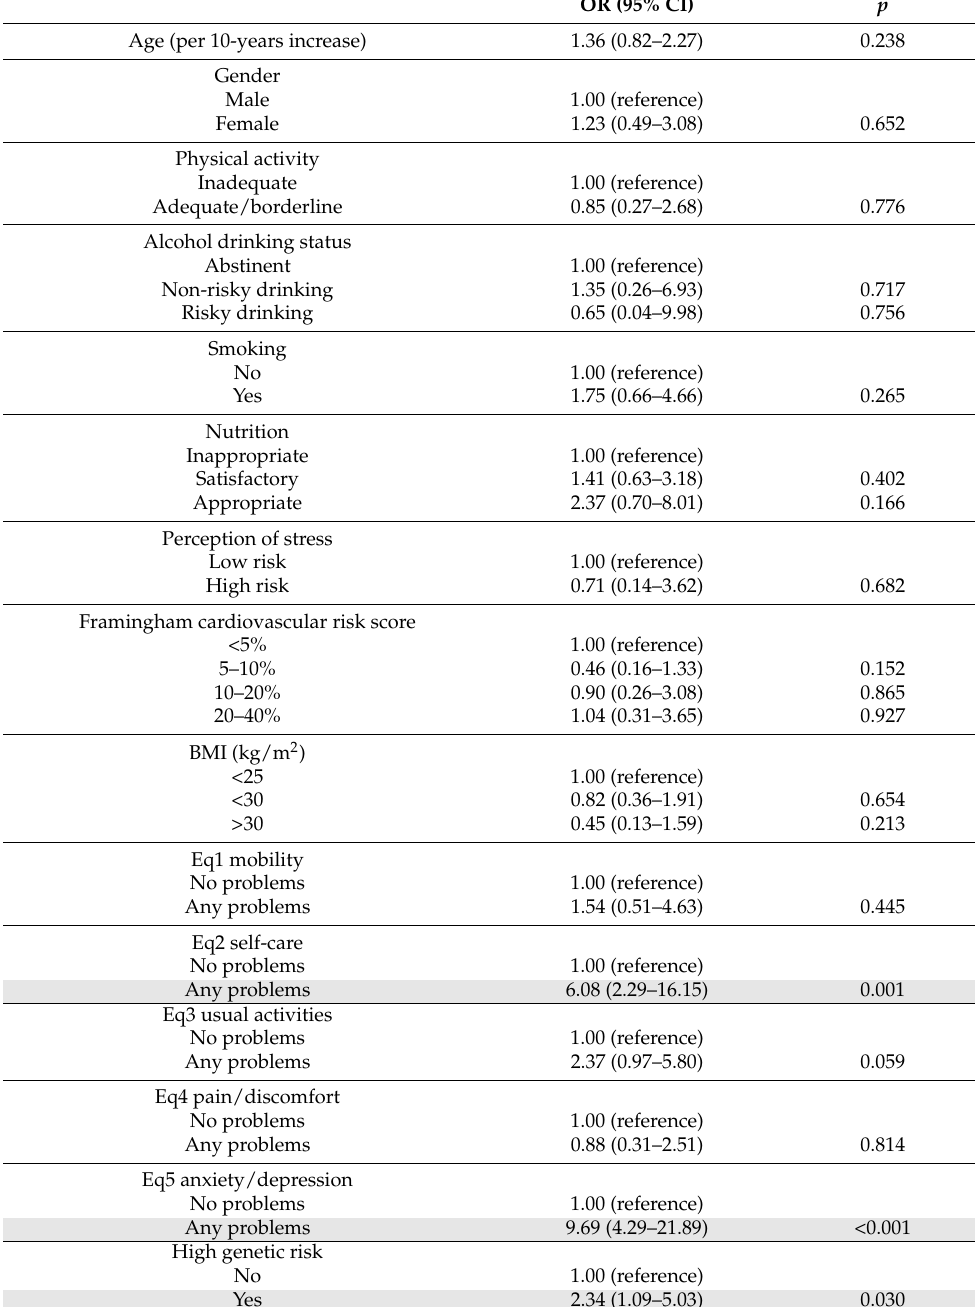
Table 2. Associations between demographic values, health status, genetic risk, and